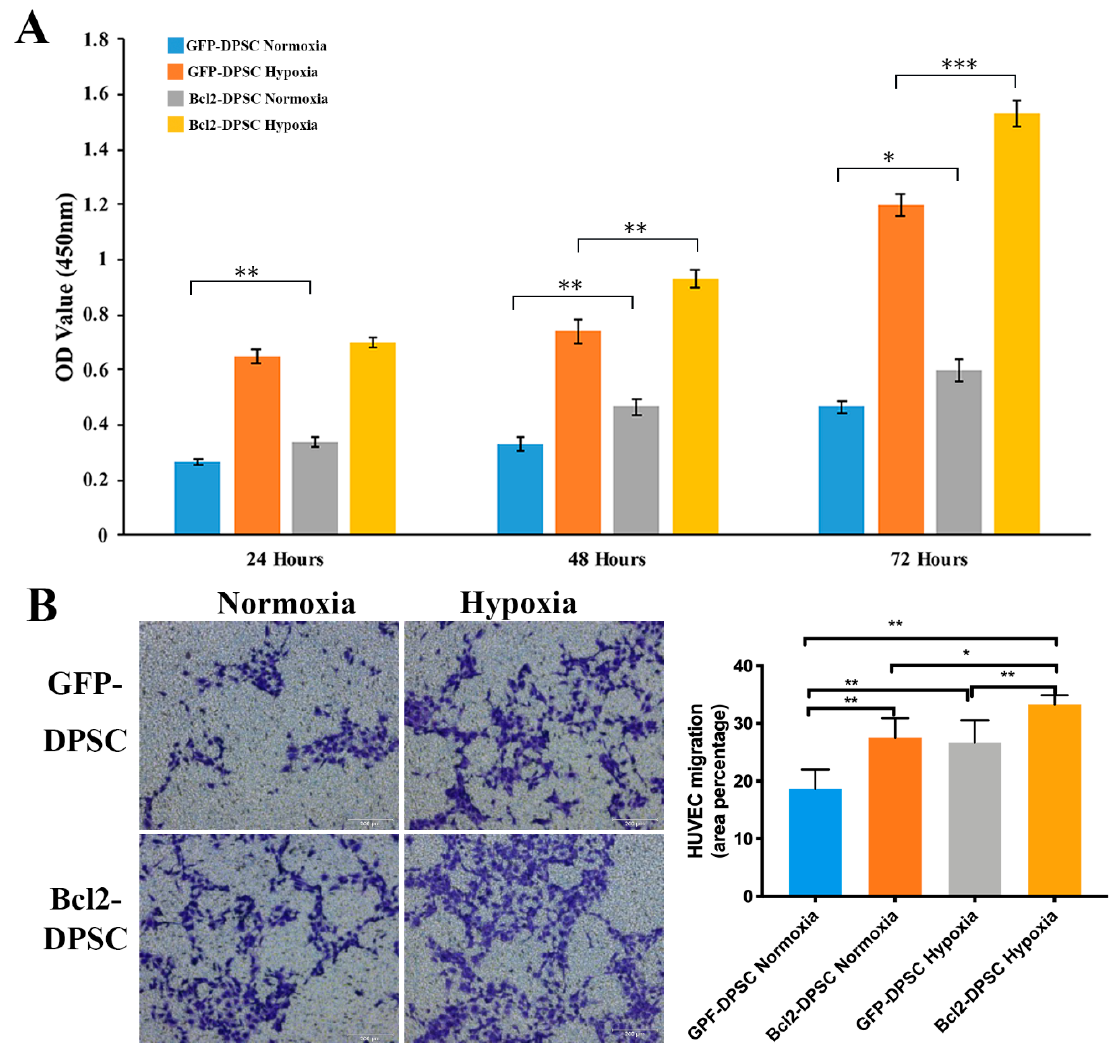
Figure 4. Paracrine e ff ects of Bcl-2-DPSCs on human umbilical vein endothelial cell (HUVEC) proliferation and migration. ( A ) Cell proliferation rates as shown by CCK-8 assay and ( B ) Transwell migrationassayofHUVECsculturedunderconditionedmediaofBcl-2-DPSCsandGFP-DPSCscollected under normoxia and hypoxia. * p < 0.05, ** p < 0.01, *** p < 0.001 versus the corresponding